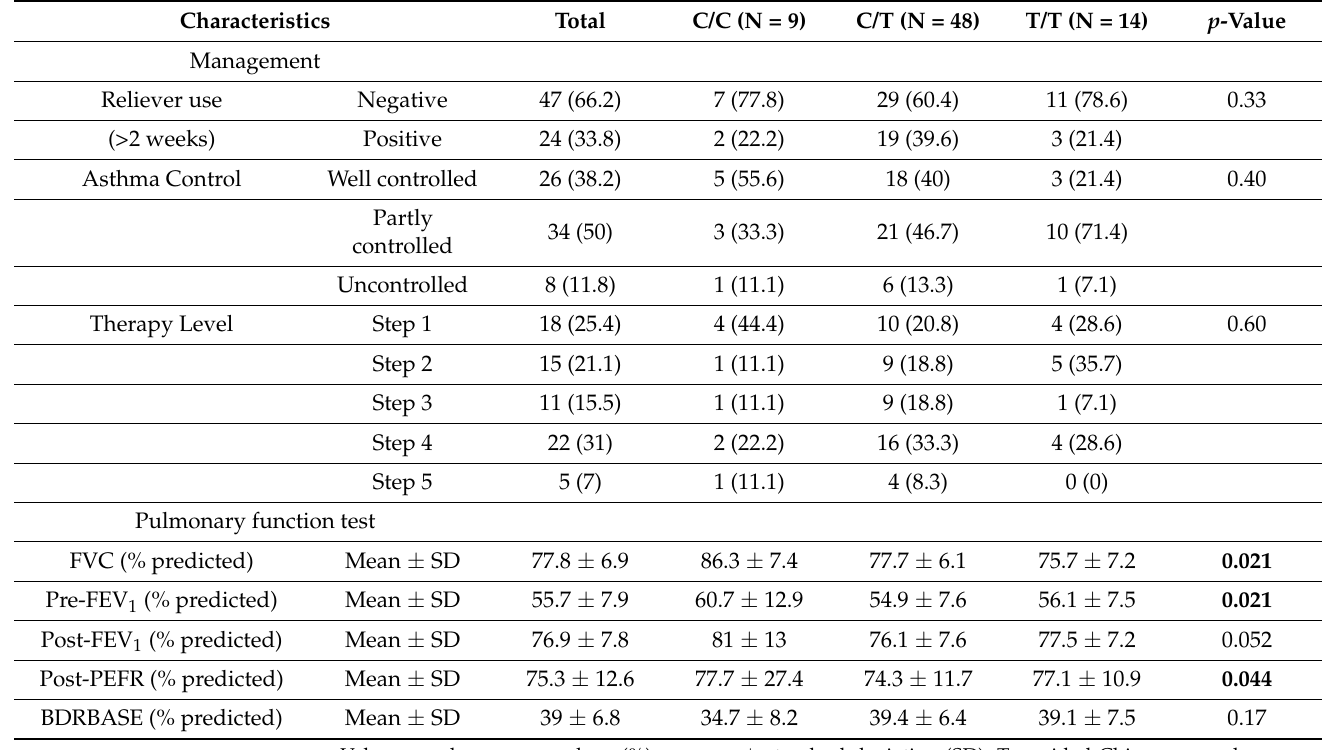
Table 5. Association of HSPA1A genotypes with demographic and clinicolaboratory data in patients with BA (N = 71